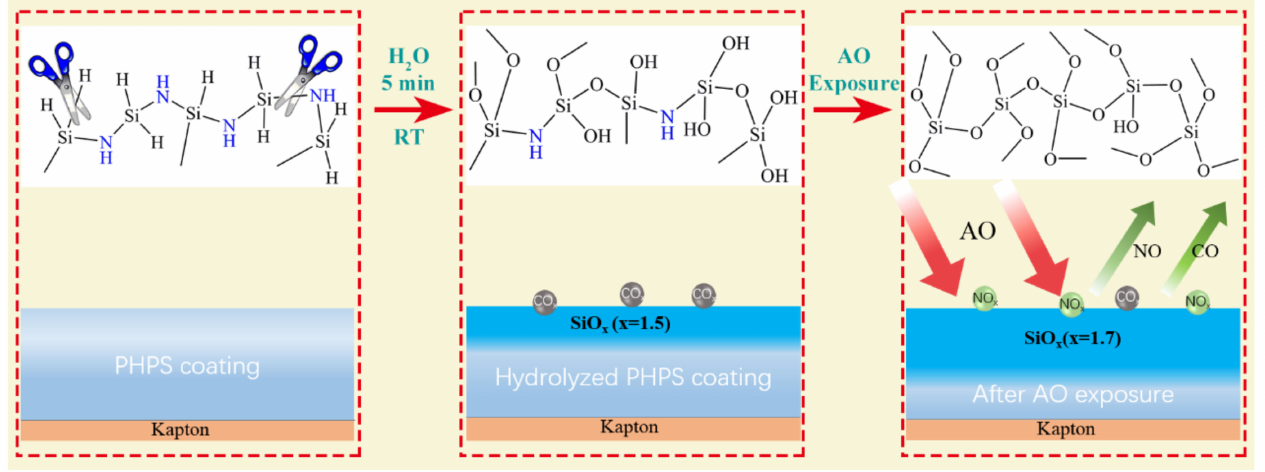
Figure 10. Schematic of the chemical reactions and the composition evolution of the PHPS coating during the hydrolysis and AO